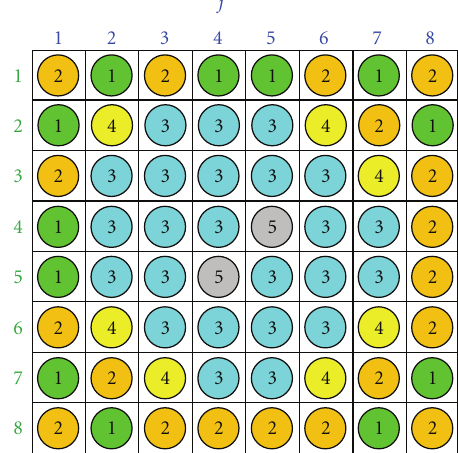
Figure 3: CHAN representation of the BFBT